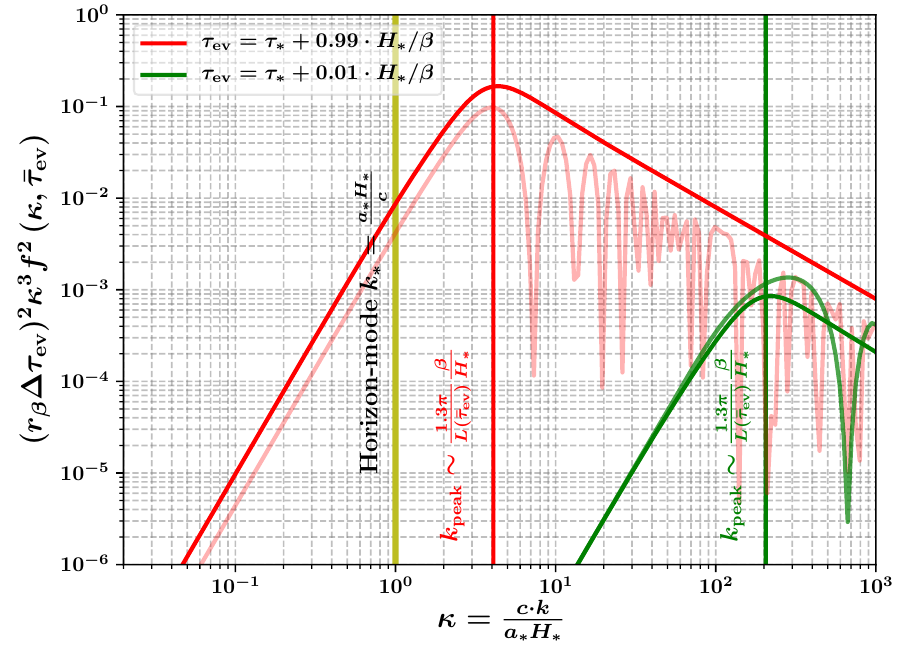
Figure 3: The dimensionless power spectrum of GWs sourced by a FPT (light red and light green) and the approximation of the time integral in Eq. (64) (bold lines) close to the start and the end of the FPT. The yellow curve shows the horizon mode. The notation is the same as in Fig.